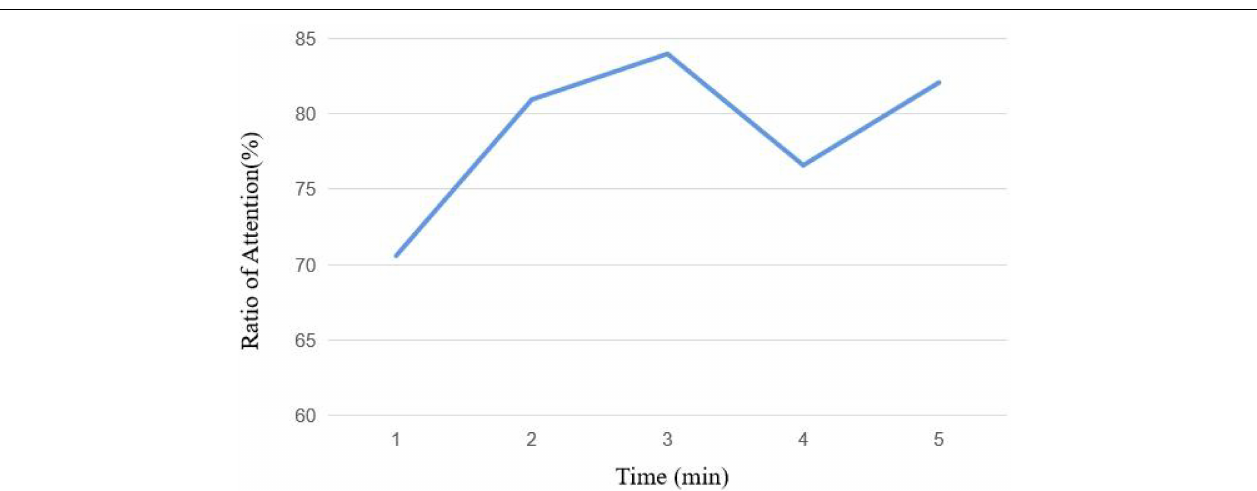
FIGURE 12 | Attention curve of course